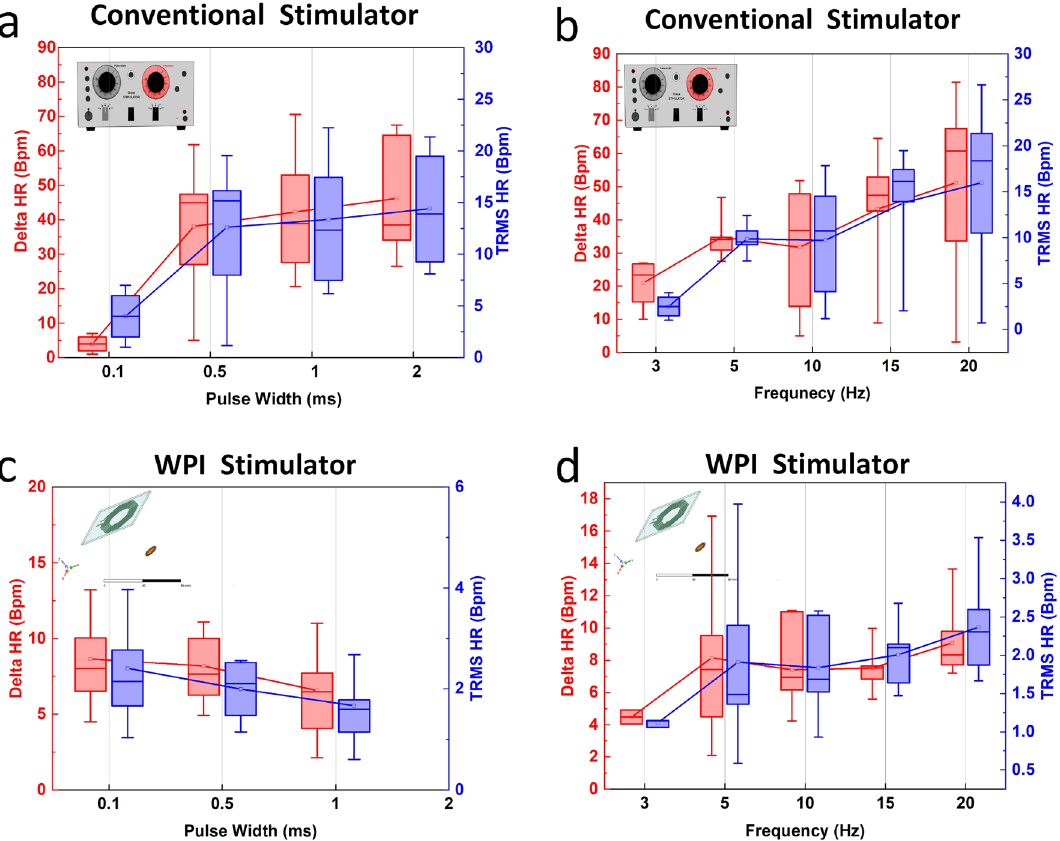
Figure 6. Comparison of conventional wired stimulators with WPI. ( a ) HR Delta and HR TRMS response to the conventional stimulator in frequency sweep. ( b ) HR Delta and HR TRMS response to the conventional stimulator in frequency sweep. ( c ) HR Delta and HR TRMS response to WPI in pulse width sweep. ( d ) HR Delta and HR TRMS response to WPI in frequnecy